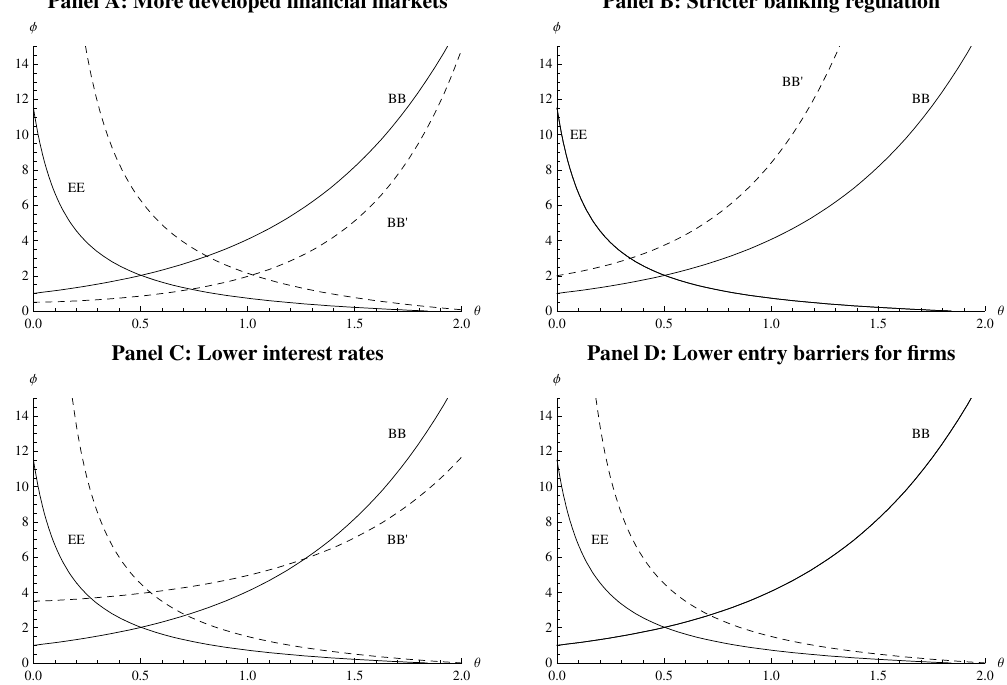
Figure 3. Finance and jobs. Note: The EE- and BB-schedules refer to equilibrium on labor and financial markets. ( B ) refers to an increase in k